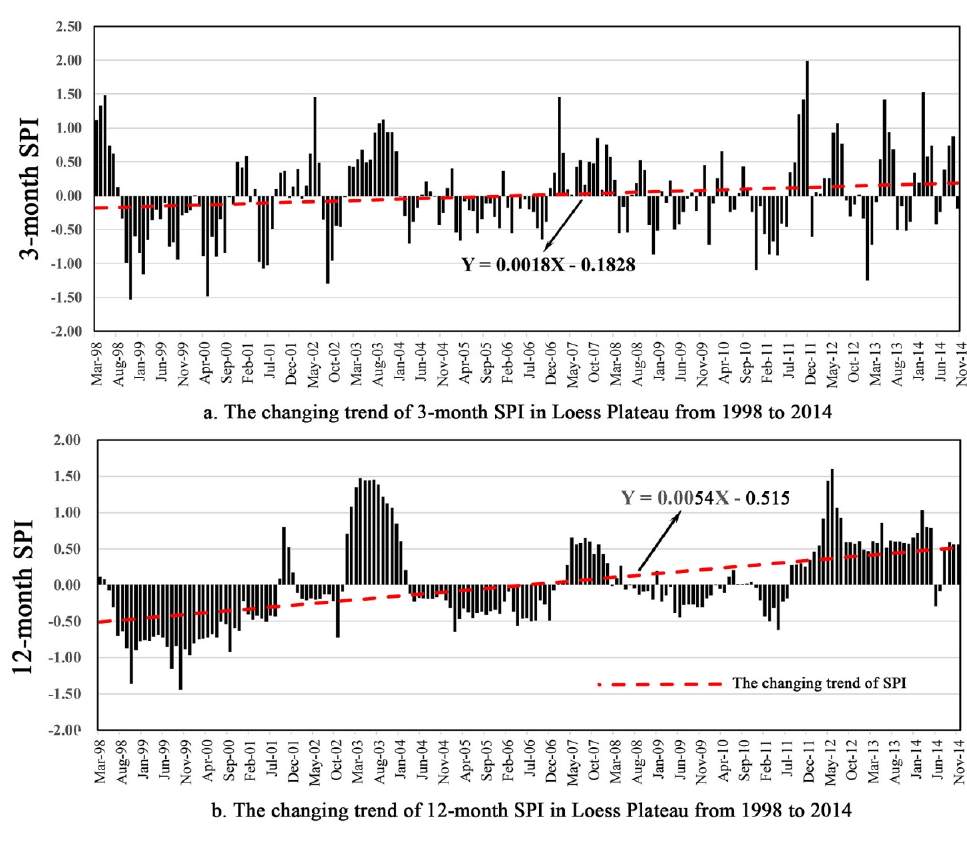
Figure 7. The temporal variation of SPI3 ( a ) and SPI12 ( b ) in the Loess Plateau from 1998 to 2014.